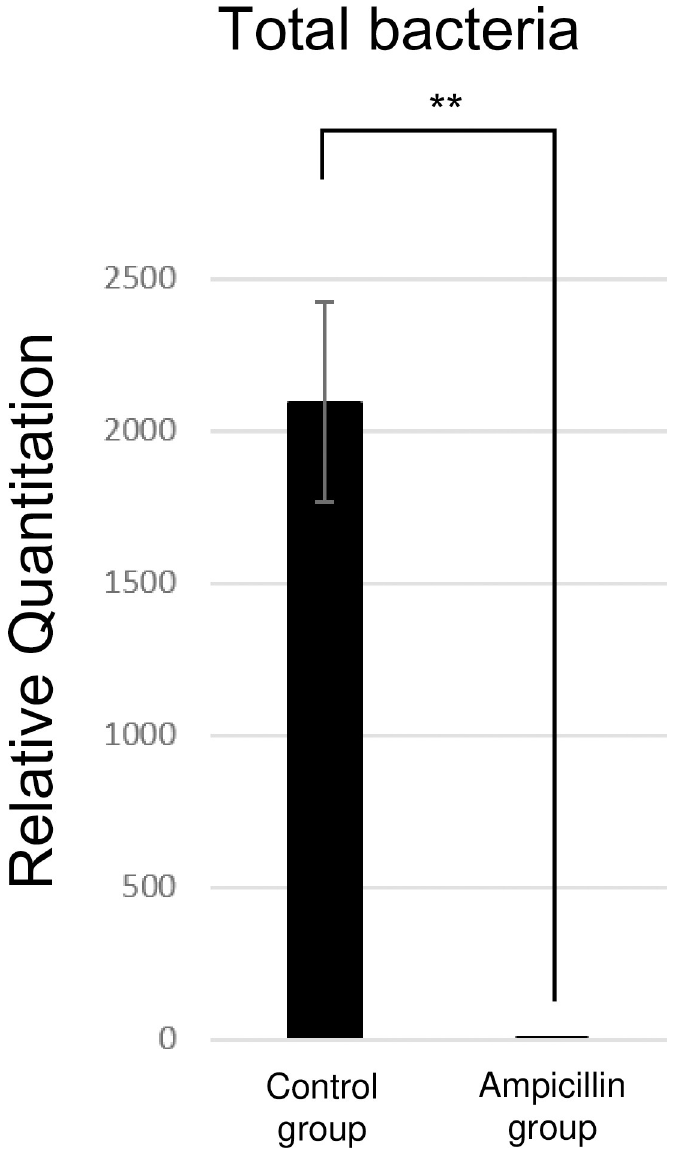
Fig 2. Relative quantification of the total bacterial population in the ampicillin-treated (A) and untreated (C) cockroach groups.